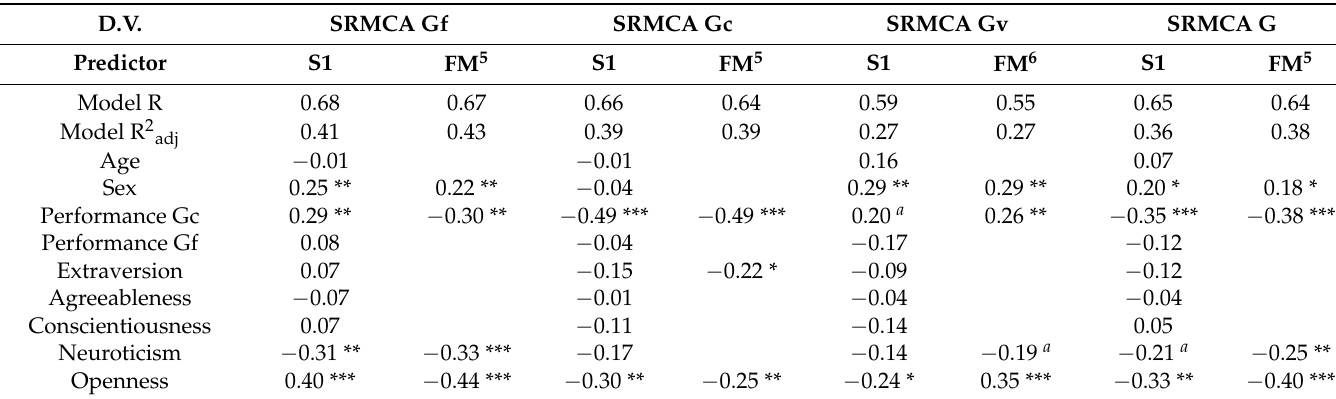
Table 4. First and final models arising from backward stepwise regression predicting SRMCA domains with demographics, cognitive performance and personality